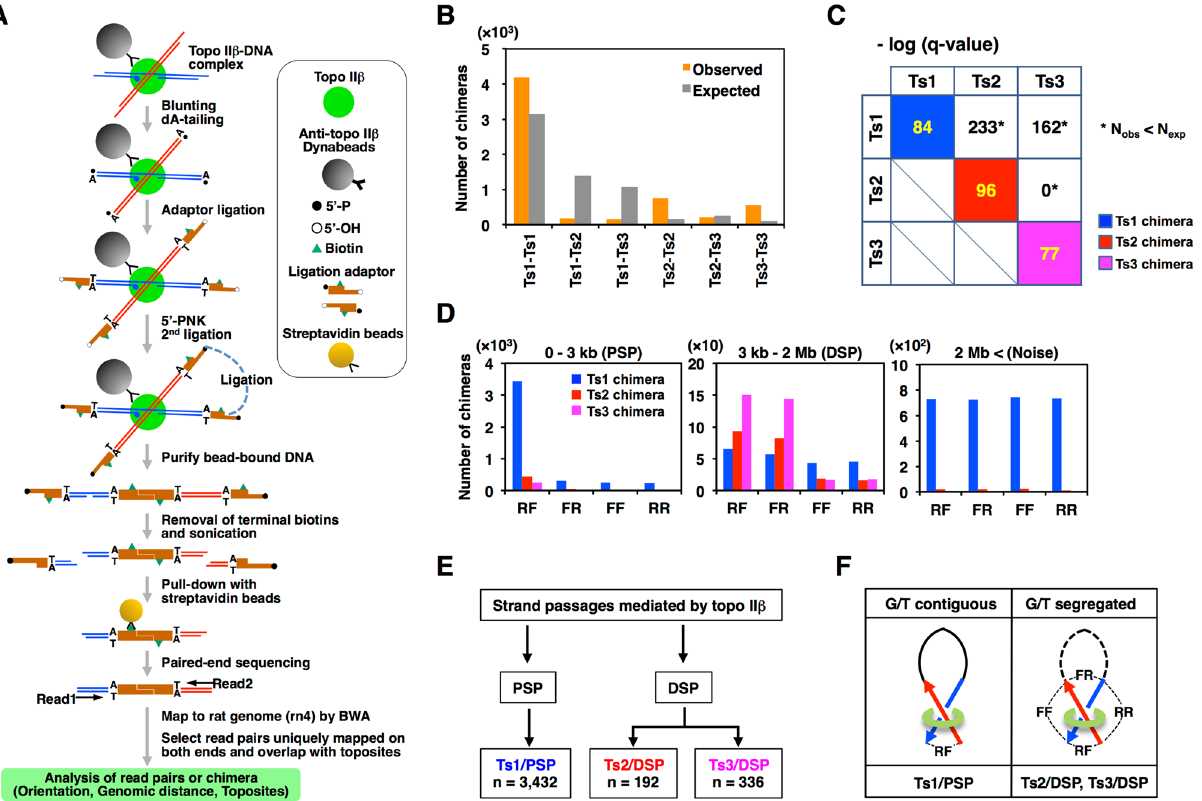
Figure 3. Analysis of chimeras identified by eTIP-seq. ( A ) A flowchart of the eTIPb-seq procedure. The topo IIβ-DNA complex was first immuno-captured on magnetic beads. Ligation reactions were conducted on beads throughout. ( B ) Toposite combinations of intra-chromosomal chimeras. Expected numbers are calculated on the basis of experimental frequencies of toposites detected at the end of chimeras. ( C ) Statistical analysis of toposite combinations. Chi-squared test was conducted between expected and observed frequencies of each combination. Resulting p-values were corrected by Benjamini–Hochberg method to obtain q-values. Shown in the matrix are minus-log transformed q-values. Asterisks indicate the combination where observed number is smaller than expected one. Chimeras with homologous combinations were highly significant and they were referred to as Ts1, Ts2, and Ts3 chimeras. ( D ) Abundance of chimeras in 3 ranges of chimera length (0–3 kb, 3 kb-2 Mb, and 2 Mb <). The first 2 groups correspond to PSP and DSP by definition and long chimeras designated ‘Noise’ are most likely to be due to ‘inter-complex chimeras’ (see text). Ts1, Ts2, and Ts3 chimeras were classified into 4 categories depending on the read combination (RF, FR, FF, and RR), which is designated by read orientations (forward = F, reverse = R) arranged in the order of upstream to downstream on the genome. ( E ) Summary of significant chimeras. Abundance of each chimera group is shown in boxes on the bottom (n). Only Ts1/PSP was considered significant for PSP and Ts1/DSP was regarded as noise signals (see text). ( F ) Probable configuration between topo IIβ and DNA crossovers. Upstream and downstream genomic segments are drawn as red and blue arrows, respectively. Thin dotted lines with read combinations indicate the adaptor ligation between the genomic fragments that are sequenced pairwise from both ends. Thick dotted line on the right represents the lost portion of genomic